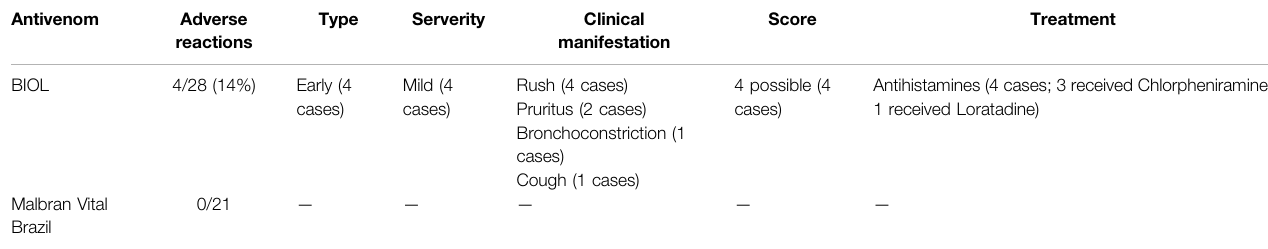
TABLE 2 | Adverse reaction of antivenoms.